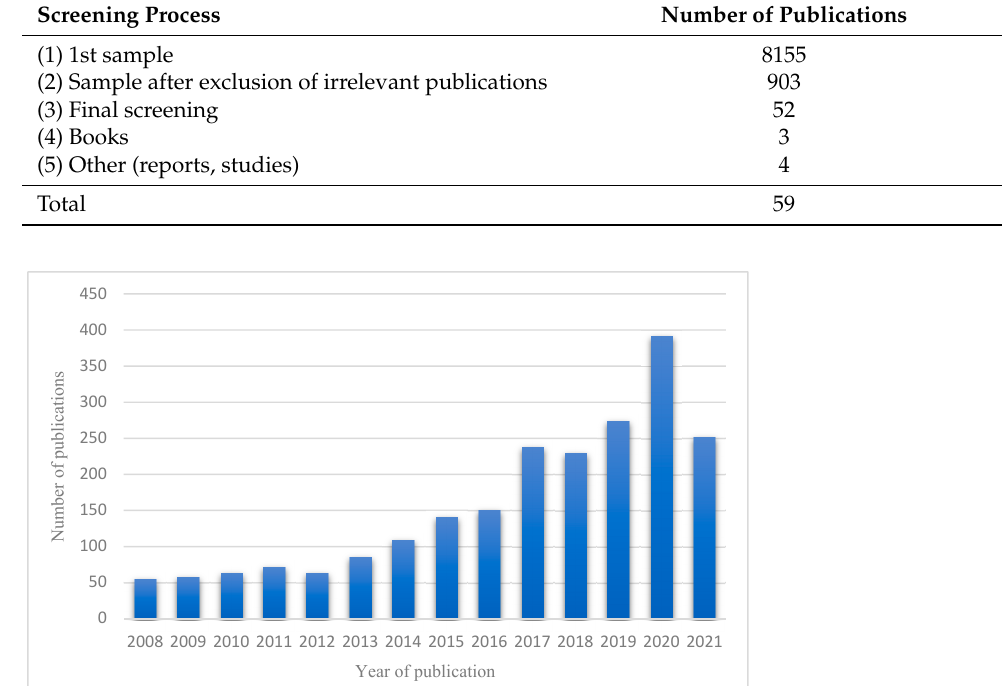
Table 1. Screening of articles on the theme “slow pyrolysis of agricultural and agro-industrial waste”. Screening Process